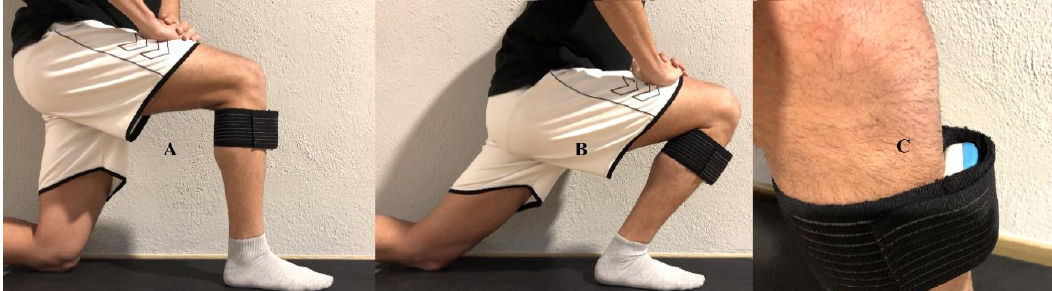
Figure 1. Athlete wearing a WIMU Pro device for the measurement of weight-bearing ankle dorsiflexion. ( A ) starting point of weight-bearing lunge test; ( B ) ending point of weight-bearing lunge test; ( C ) WIMU Pro device in touch with the tibia.